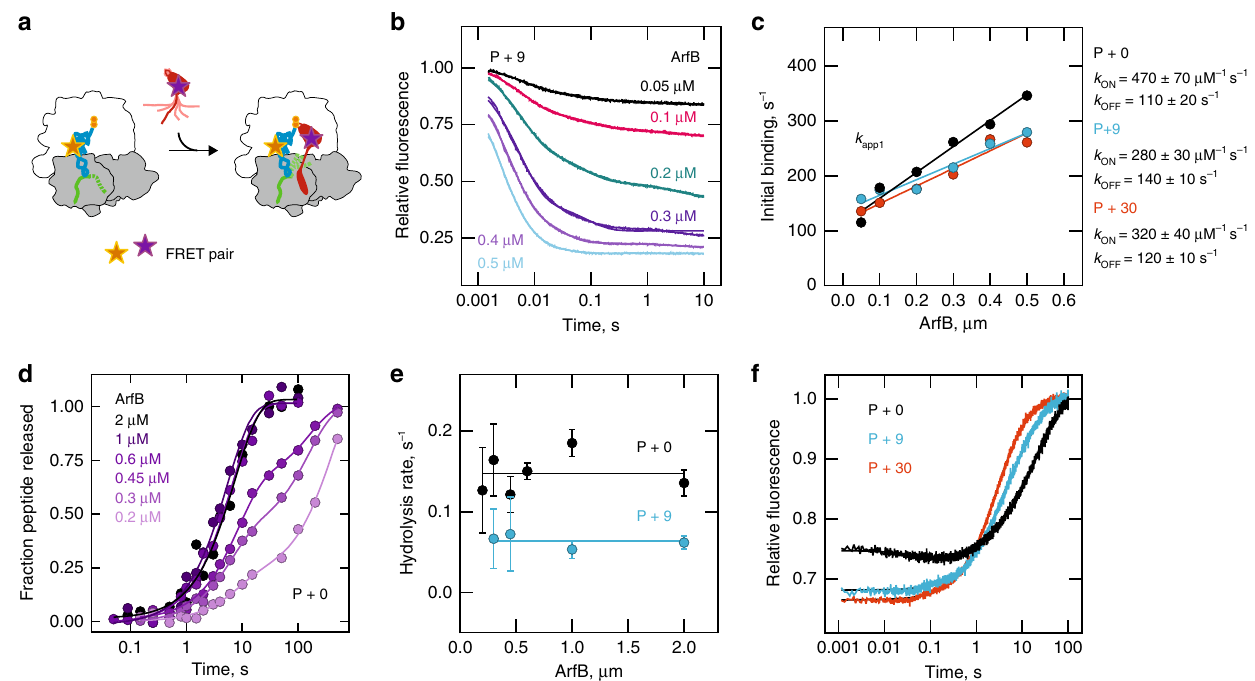
Fig. 4 A dynamic model of ArfB recruitment. a Experimental assay to monitor binding of ArfB to the ribosome in real time. P + n ribosome complexes containing fl uorescein-labeled fMetPhe-tRNA Phe (P + n (Flu)) are mixed with quencher-labeled ArfB (ArfB(540Q)) and fl uorescein quenching is monitored in real time in a stopped- fl ow apparatus. b Time courses of ArfB binding with fi xed concentration of P + 9(Flu) (0.015 µ M) and increasing concentrations of ArfB(540Q) (0.05-0.5 µ M) (20 °C). Lines indicate three-exponential fi ts. c Kinetics of initial binding of ArfB(540Q) to P + 0(Flu), P + 9(Flu), and P + 30 (Flu) complexes. Plotted is the concentration dependence of the apparent rate constant ( k app1 ) for the predominant association phase in ( b ). Data represents the mean values of two biological replicates with up to six technical replicates each. The association ( k ON ) and dissociation ( k OFF ) rate constants are determined by linear fi tting of the concentration dependence. Errors of k ON and k OFF values are SEM of the fi t. d Kinetics of peptidyl-tRNA hydrolysis. Time courses of hydrolysis with P + 0 ribosome complex (0.15 µ M) and ArfB (0.2 – 2 µ M) (37 °C). Data represented as mean values of two biological replicates. e Comparison of peptidyl-tRNA hydrolysis rates on P + 0 and P + 9 complexes. Values are obtained by exponential fi tting of the rapid phase of the hydrolysis time courses ( d and Supplementary Fig. 4f). Error bars represent the SEM of the fi t. f Dissociation of ArfB from P + 0, P + 9, and P + 30 complexes. The release of ArfB GAQ (540Q) (0.1 µ M) from the pre-hydrolysis complexes P + 0(Flu), P + 9(Flu), and P + 30(Flu) (0.015 µ M) was initiated by rapid mixing with unlabeled P + 0 complexes (1 µ M) (20 ArfB GAQ (Flu), a hydrolysis-de fi cient ArfB mutant (Gly27 to Ala),